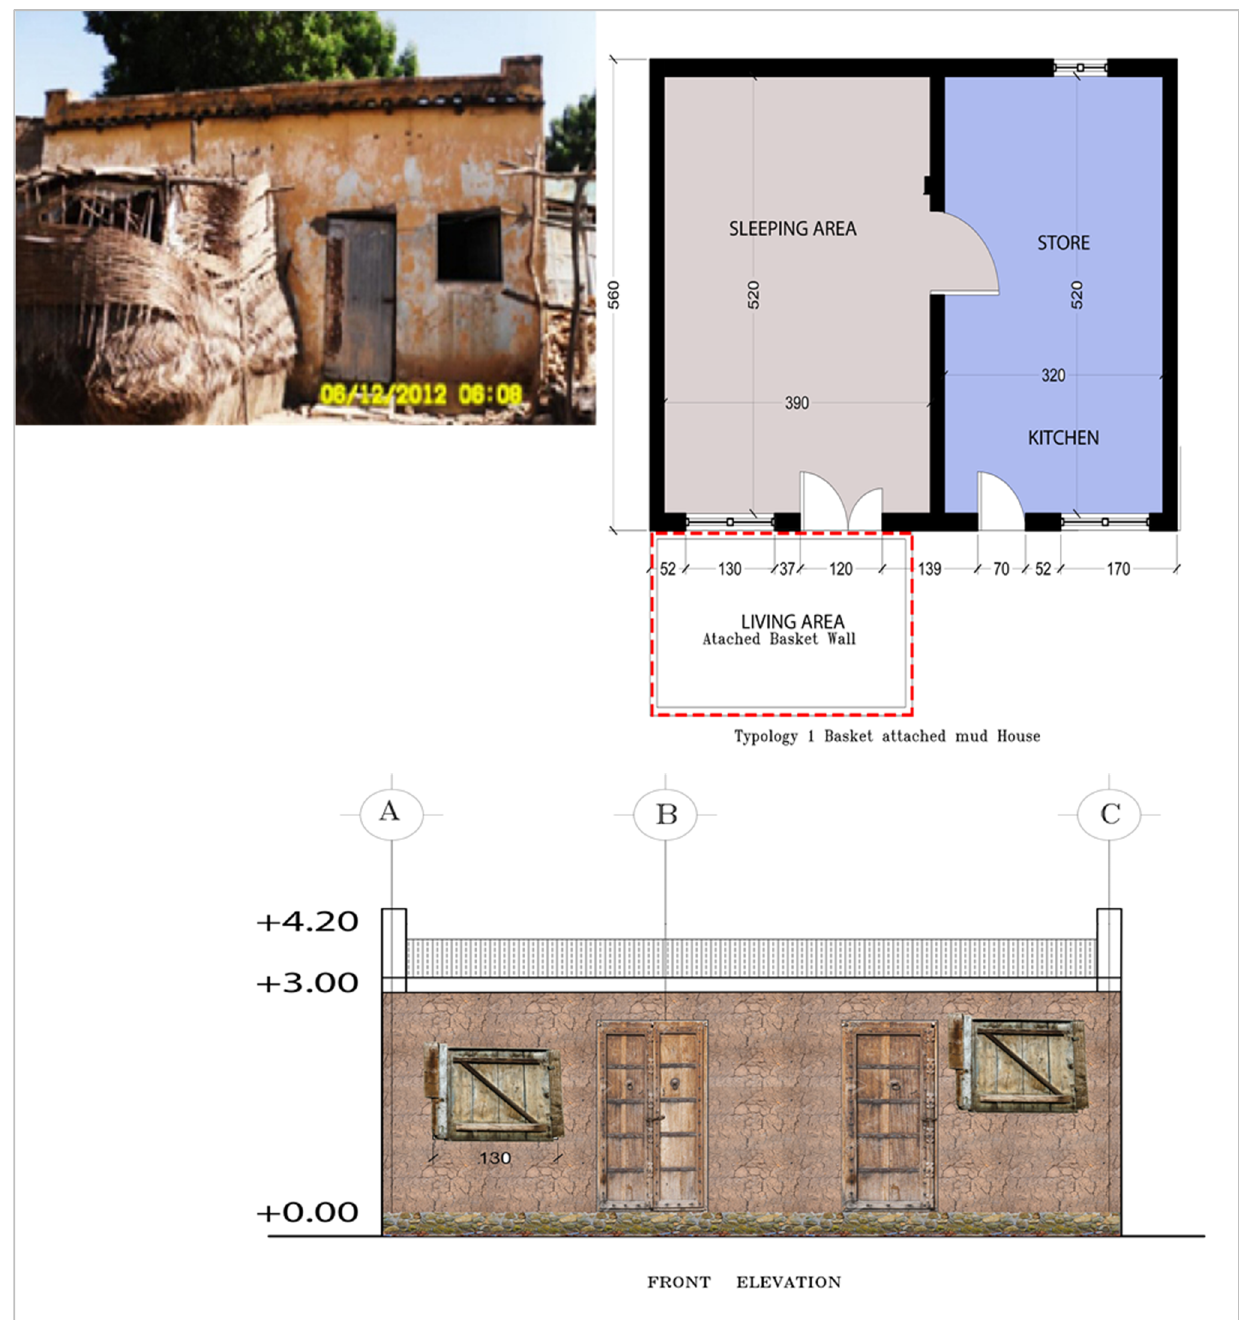
Figure 9. Old thick brick house with a basket shelter extension. The thick brick walls have a high thermal mass, which is one of the key ecological characteristics of these houses. The majority of old thick brick houses have small unglazed window openings on the top or just one regular unglazed window per room (Figure 10).